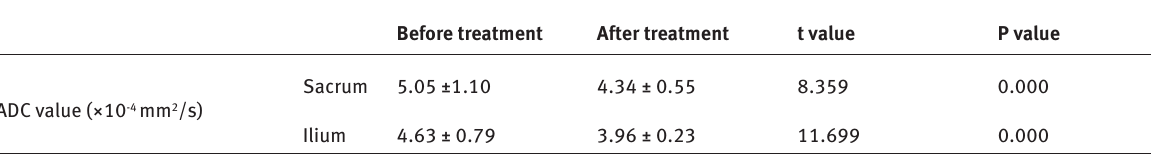
Table 1: Index difference between control and experimental group